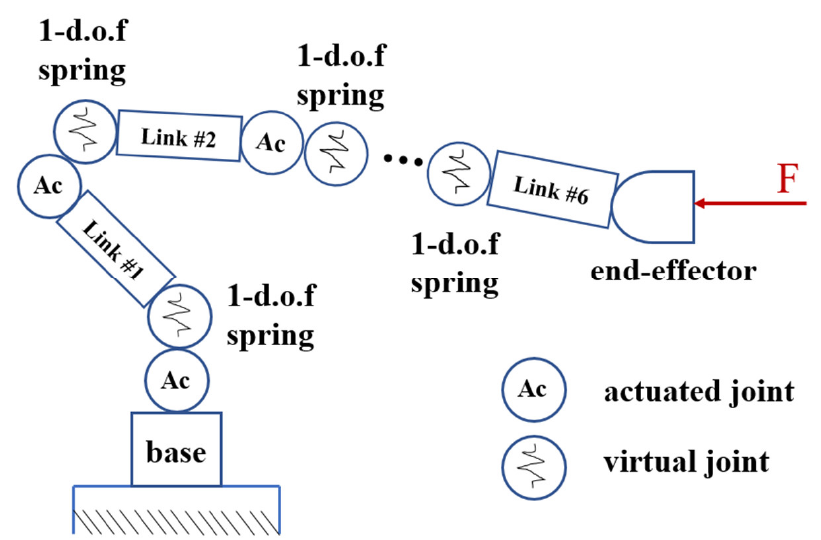
Figure 7. Schematic diagram of the serial robot with the VJM method.